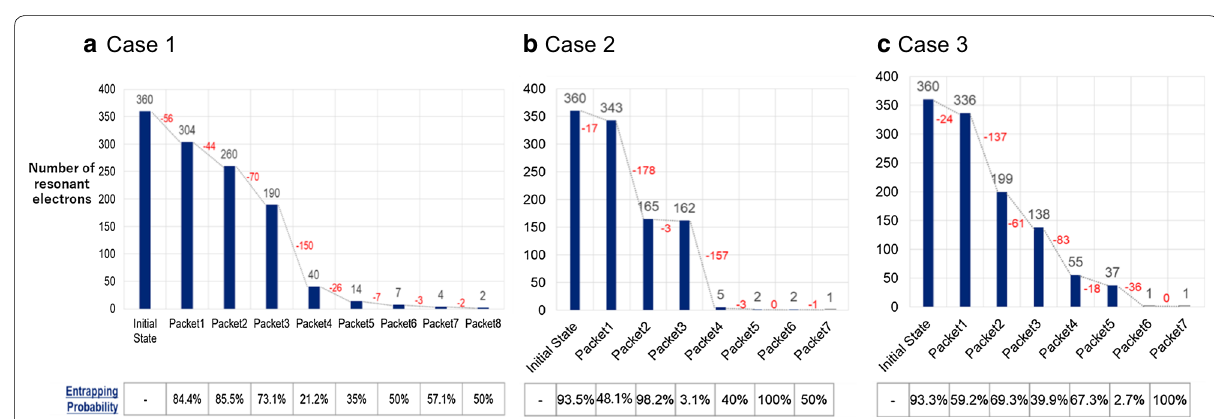
Fig. 11 Transitions of number of the resonant electrons and trapping probability in case 1 (500 keV-60°), case 2 (2.1 MeV-80°), and case 3 (5.7 MeV-86°). a In case 1, out of 360 electrons initially in resonance with the chorus wave, only 304 electrons are entrapped by the first subpacket (packet 1), and 56 electrons are shortly detrapped and get off resonance. Hence the trapping probability of packet 1 is 84.4%. In the same manner, 260 electrons out of the 304 electrons are consecutively entrapped by packet 2. Hence the trapping probability of packet 2 is 85.5%. The probability of successive trapping (trapping by more than one subpackets) in case 1 is 72.2%. b Similarly, the trapping probabilities for each packet in case 2 are shown in the table, and the probability of successive trapping is 45.8%. c The trapping probabilities for each packet in case 3 are shown in the table. The probability of successive trapping in case 3 is 55.3%. It can be seen that the probability of successive trapping is higher in the lower energy case (RTA acceleration case) such as case